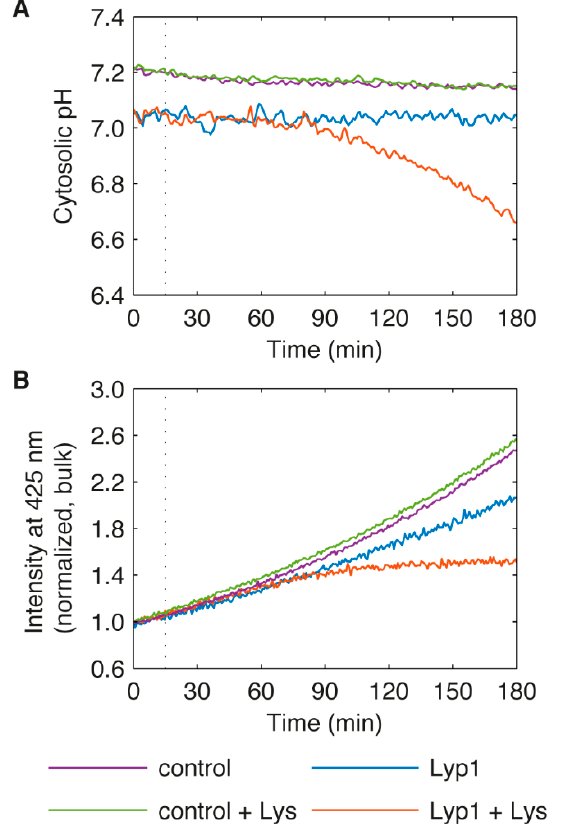
Figure 5. The effect of external lysine on the cytosolic pH of cells overexpressing Lyp1. BY4741 expressing the pH-sensitive ratiometric pHluorin and carrying the empty plasmid pRSII425 was used as a control. The Lyp1 strain constitutively expresses both pHluorin and a truncated, non- fluorescently tagged Lyp1. ( A ) Cytosolic pH. ( B ) Normalized bulk intensity at 425 nm excitation/508 nm emission, at which pHluorin is largely insensitive to pH. Values shown are the mean of two independent experiments (individual results are shown in Figure S6). Dotted lines indicate the time at which either distilled water or lysine (final concentration 500 µM) was added.